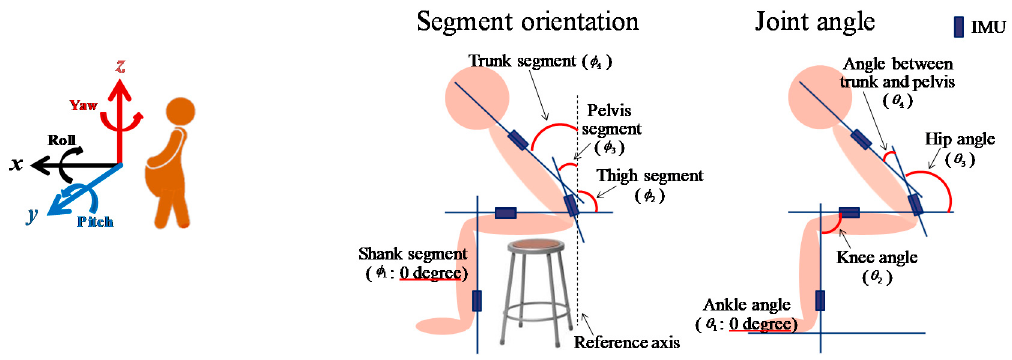
Figure 2. Coordinate system ( left ) and definition of orientations and angles ( right ). Calculated orientations of body segments and joint angles from each IMU are shown, where θ and φ correspond to the symbols in Equation (1).